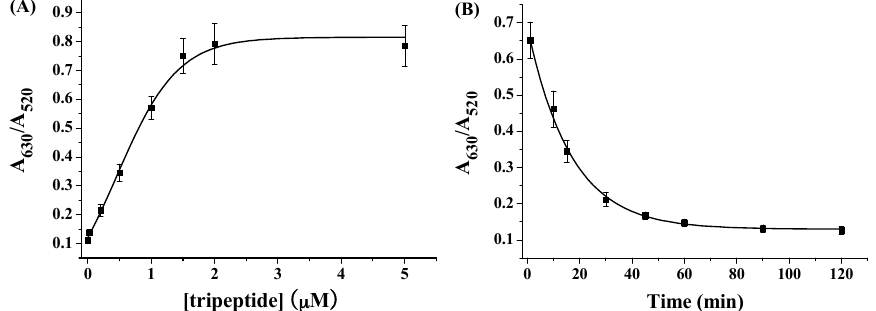
induced the decrease in the absorbance at 630 nm. The dependence of the A 630 /A 520 on the DPP-IV concentration was shown in Figure 3C. It can be observed that A 630 /A 520 decreased linearly with DPP-IV concentration in the range of 0.1–50 mU/mL. The linear regression equation can be expressed as A 630 /A 520 = 0.725 [DPP-IV] (mU/mL) − 0.008, R = 0.993. The detection limit was determined to be 70 μ U/mL based on the slope of the dose-response curve and the standard deviation of blank responses ( n = 11). It has been suggested that DPP-IV inhibitor can increase the half-life of incretins, decrease the concentration of plasma glucose, and improve impaired glucose